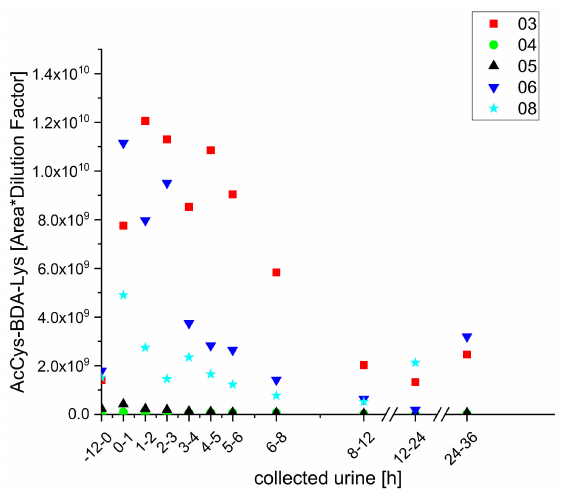
Figure 4. Excretion kinetics of AcCys-BDA-AcLys: UPLC-qToF-MS / MS measurements of contents in samples of urine from participants three, four, five, six, and eight at indicated times after co ff ee consumption (h).